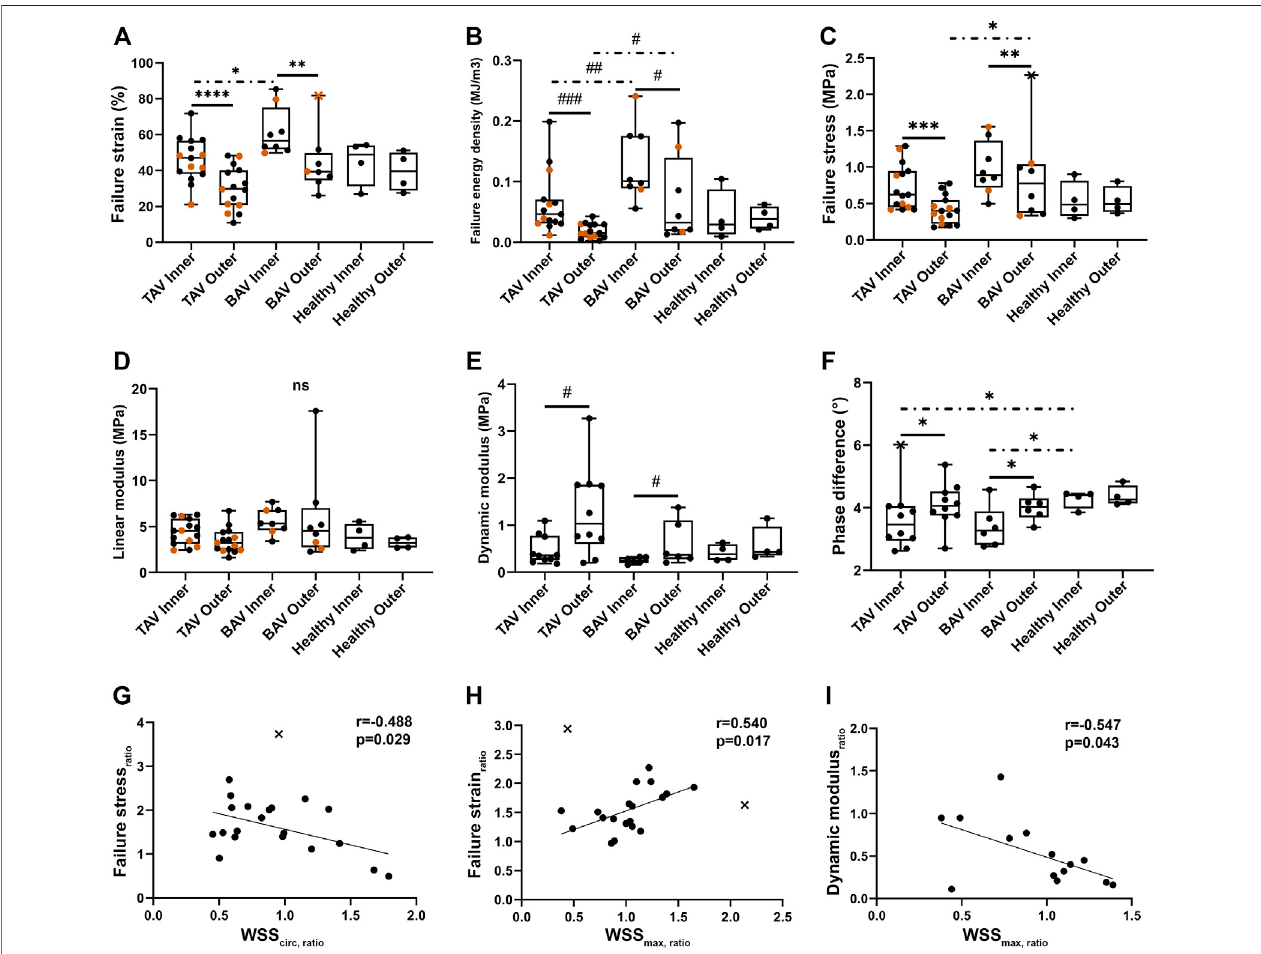
FIGURE3|(A – F) BoxplotsofthebiomechanicalpropertiesfordilatedAAwithTAVorBAV,andhealthysubjectswithmedianandoutliers(acrossmark).Theblack and vermilion circles present the 17N and 250N (less accurate) load cells, respectively. (G – I) Correlations were detected between circumferential WSS ratio and failure stress (G) ratio and between maximum total WSS ratio and failure strain (H) and dynamic modulus (I) ratios. p -values < *0.05, < **0.01, < ***0.001, < ****0.0001, ns not signi fi cant. Asterisk: parametric test, hash sign: non-parametric test, solid line: paired experiment, dot-dash line: unpaired experiment.